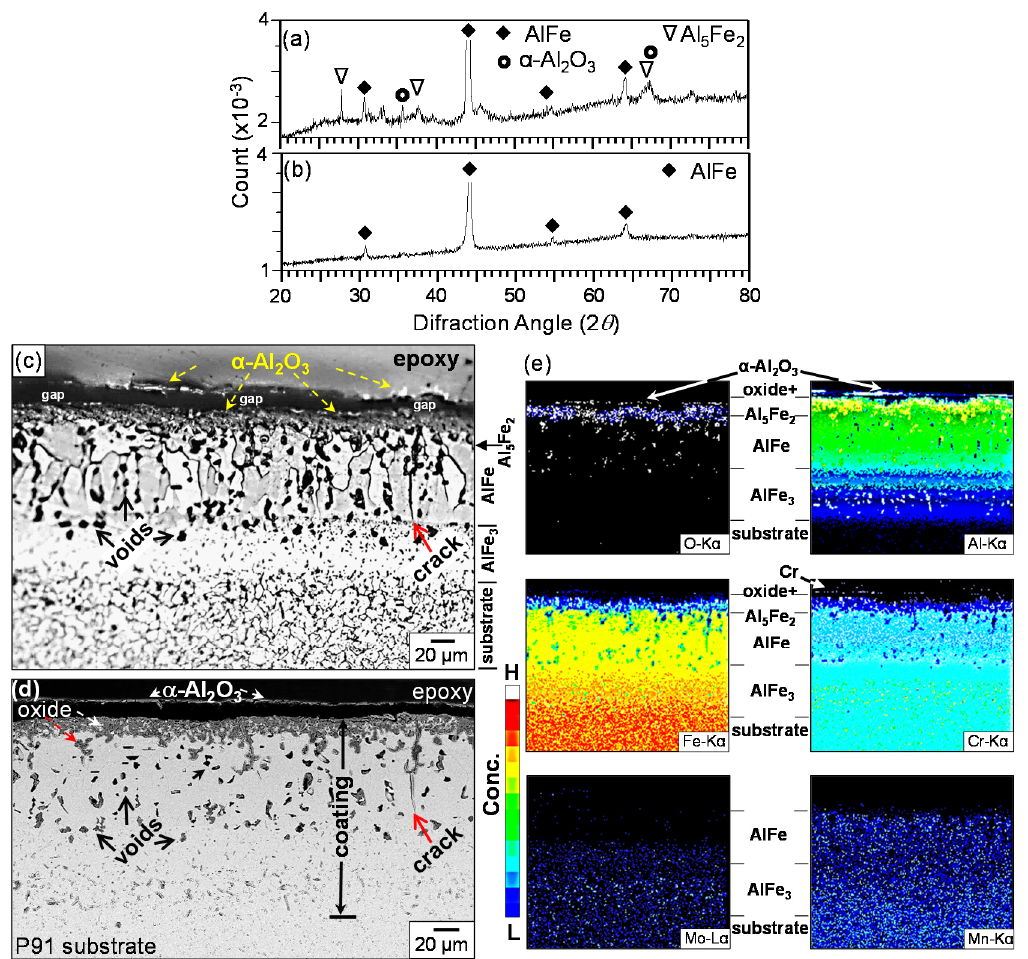
Figure 5. Al hot ‐ dipped P91 steel after oxidation at 800 °C for 100 h. ( a ) XRD pattern before grinding; Figure 5. Al hot-dipped P91 steel after oxidation at 800 ◦ C for 100 h. ( a ) XRD pattern before grinding; ( b ) XRD pattern after grinding off the surface; ( c ) cross ‐ sectional optical microstructure (etched); ( b ) XRD pattern after grinding off the surface; ( c ) cross-sectional optical microstructure (etched); ( d ) EPMA BSE cross ‐ sectional image; ( e ) EPMA maps of (d). ( d ) EPMA BSE cross-sectional image; ( e ) EPMA maps of ( d